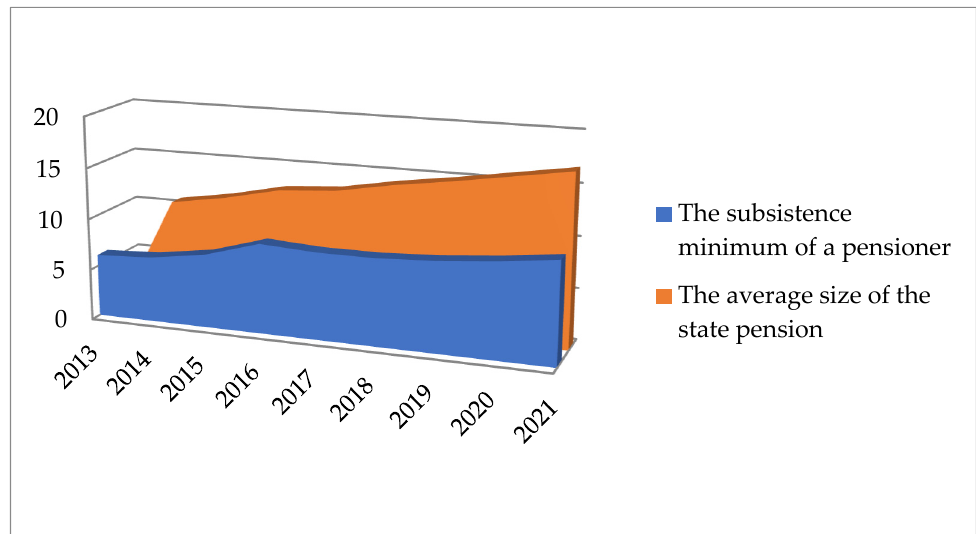
Figure 3. Dynamics of the average size of the state pension and the subsistence minimum of a pensioner in Russia, thousand rubles.